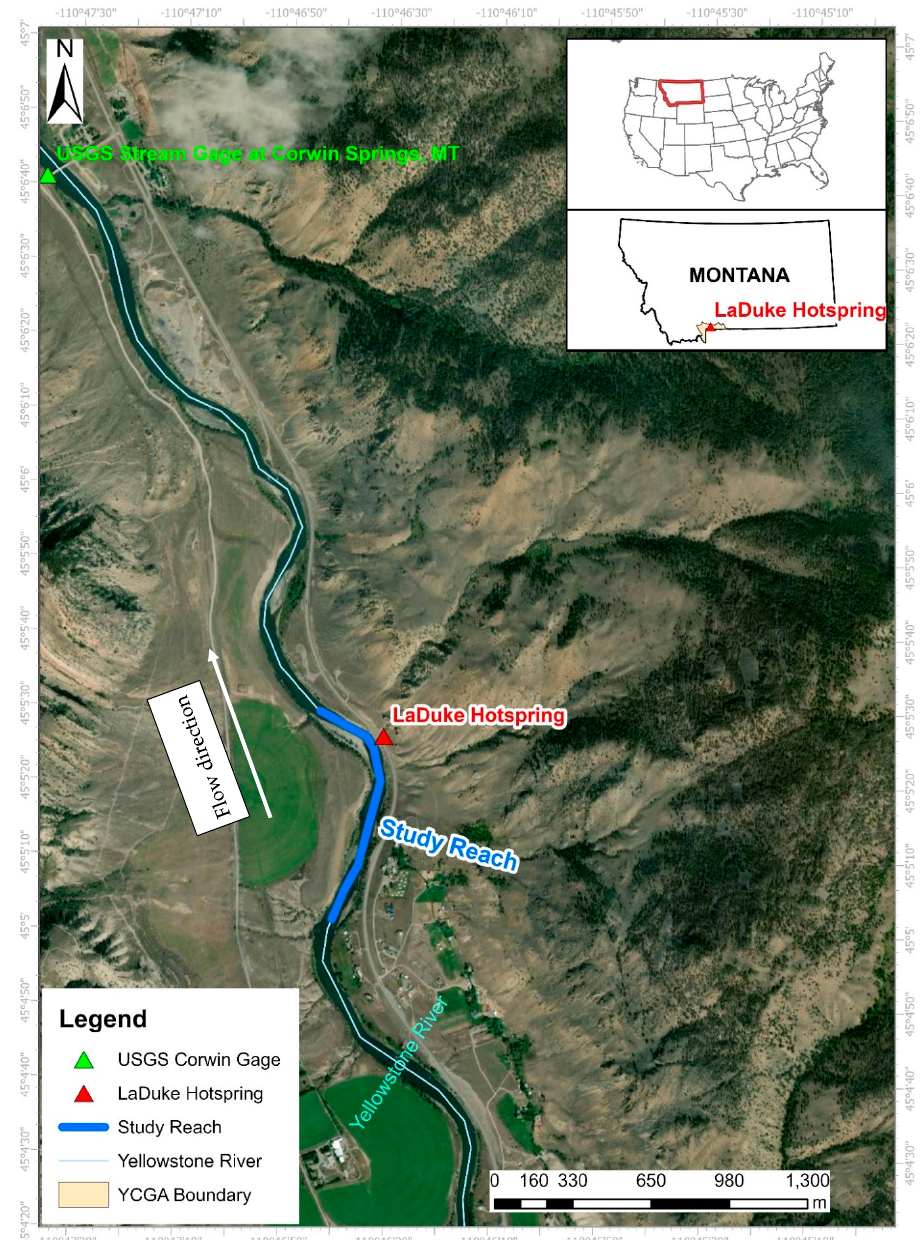
Figure 1. Map showing the study area and key features. “YCGA Boundary” refers to Yellowstone Controlled Groundwater Area. Credits for the background service layer: United States Department of Agriculture Farm Service Agency (USDA FSA), GeoEye Inc., and